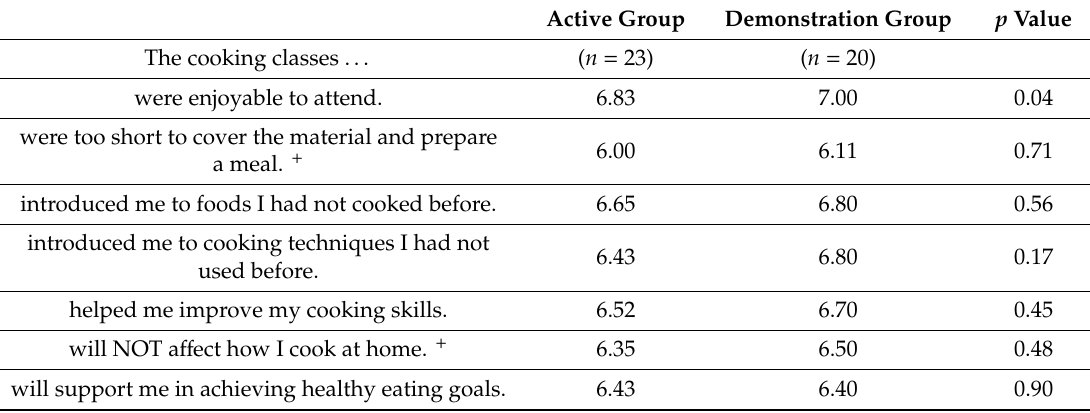
Table 5. Cooking class evaluation statements and group Likert scale